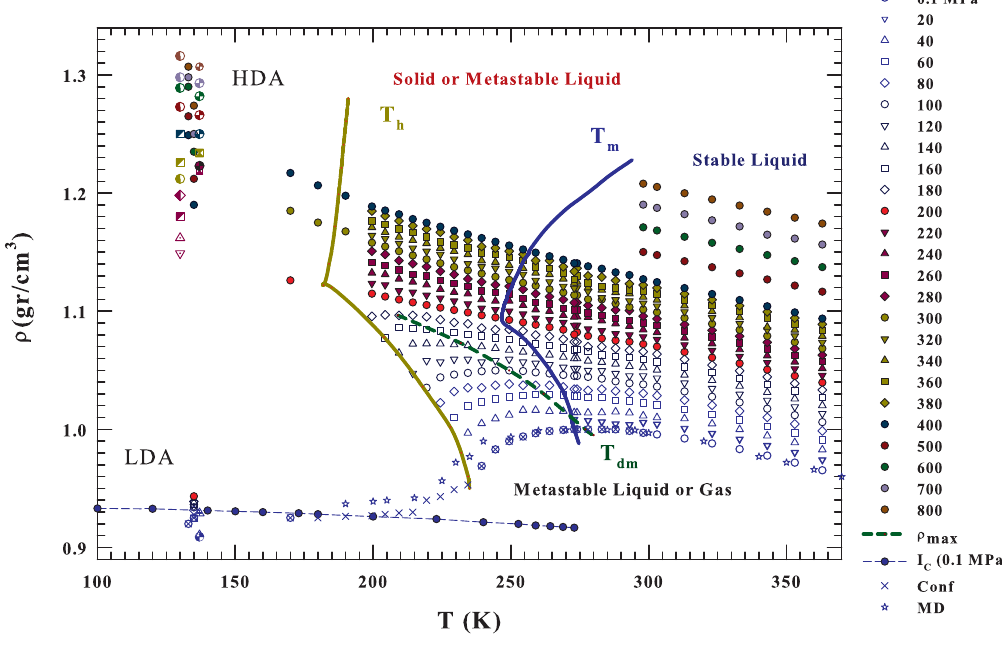
Figure 2. Bulk water density isobars, from 0.1 to 800 MPa , in the T range from 100 to 370 K (i.e., from the values of the two amorphous phases LDA and HDA to the stable lquid region. The corresponding data come from some different experiments; the figure also reports data of: the LDA and HDA [6,30–32] and bulk liquid water [3,19,56–61]. Are also included, for P = 0.1 MPa, the ice Ic densites and those coming from a simulation of the equation of state by using the TIP4P/2005 water model [37] with the experimentally obtained for water inside hydrophilic nanotubes [51]. The HDA, LDA and the liquid densities, measured at a give pressure, are reported in the same color. From the data evolution inside the metastable supercooled region there is the clear suggestions that for P ≥ 200 MPa the liquid water data evolves on to the HDA value; viceversa the lower pressures evolution is only towards the